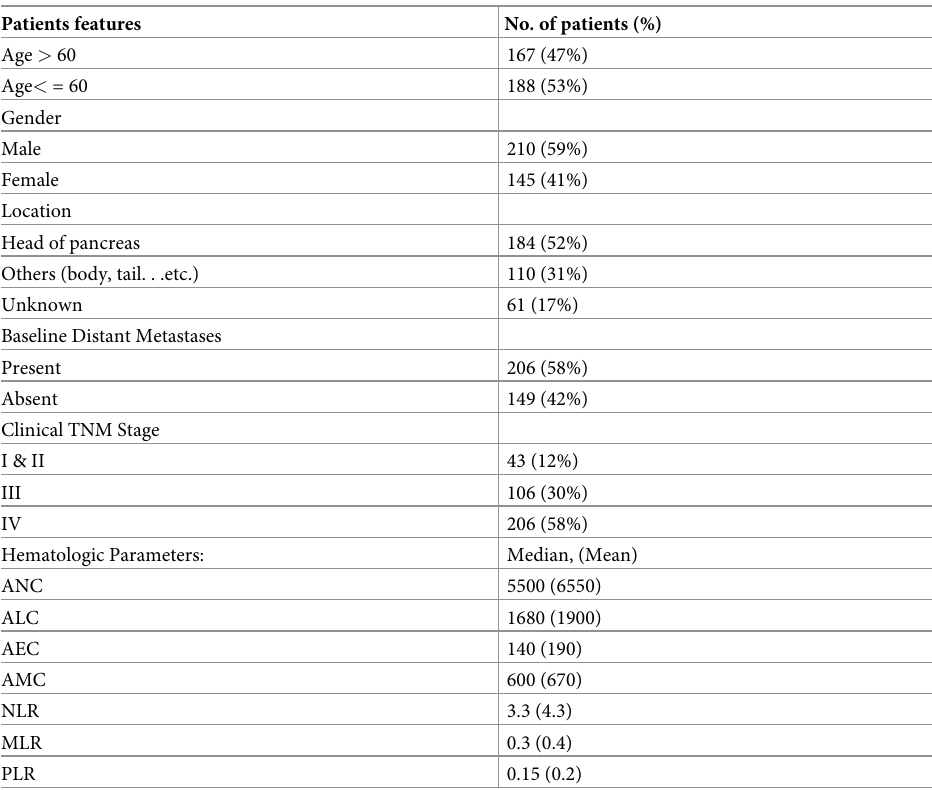
Table 1. Characteristics of pancreatic cancer patients. Patients